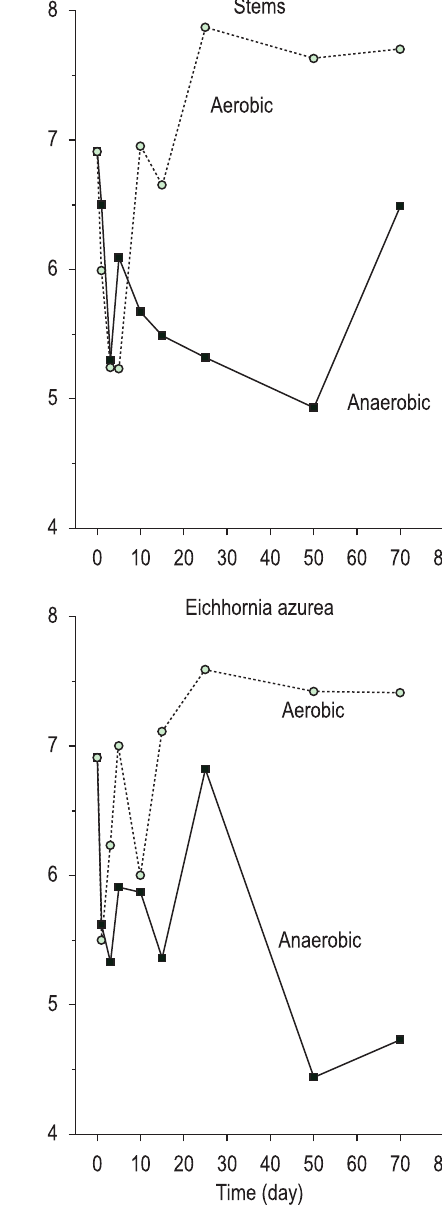
Figure 3. Temporal variations of pH during the decomposition of leaves, stems, roots and Eichhornia azurea under aerobic and anaerobic